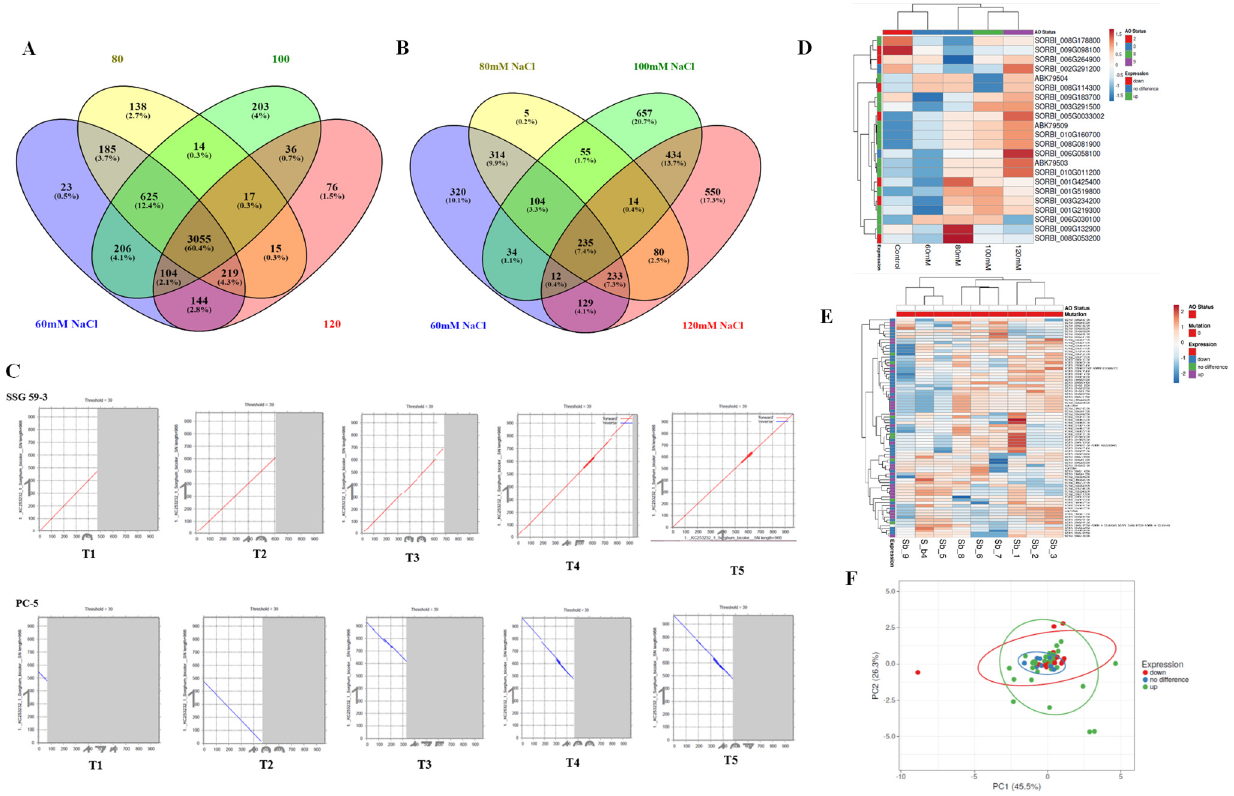
Figure 12. Number and grouping of DEGs. ( A , B ) Venn diagram analysis of DEGs identified in sorghum genotypes under the five experimental comparisons. Principal component analysis (PCA) showing clusters under different salinity treatments in sorghum genotypes. ( C ) Overview of DEGs SSG59-3 and PC-5, ( D , E ) heatmap representing top 22 up- and downregulated transcripts, ( F ) principal component analysis of the clusters as per the treatment.